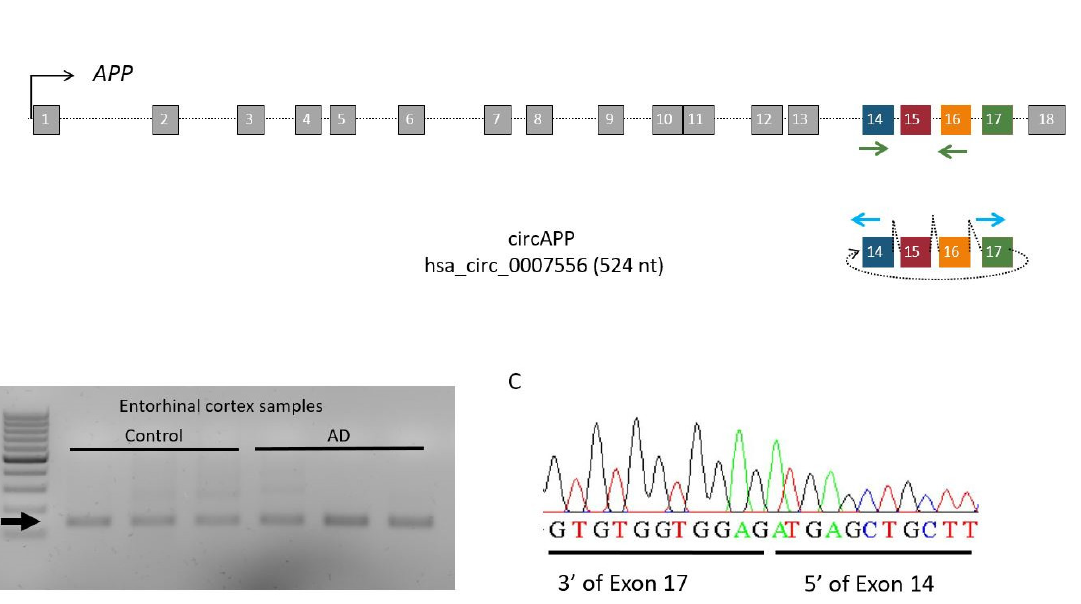
Figure 1. Identification of circAPP (hsa_circ_0007556). ( A ) Schematic representation of circAPP (hsa_circ_0007556) and APP mRNA, arrows represent primers (blue arrows for circAPP (hsa_circ_0007556) divergent and green arrows for APP mRNA). ( B ) Electrophoresis agarose gel of circAPP (hsa_circ_0007556), arrow points the circAPP (hsa_circ_0007556) PCR product. ( C ) Electropherogram showing the circAPP (hsa_circ_0007556) covalent junction.